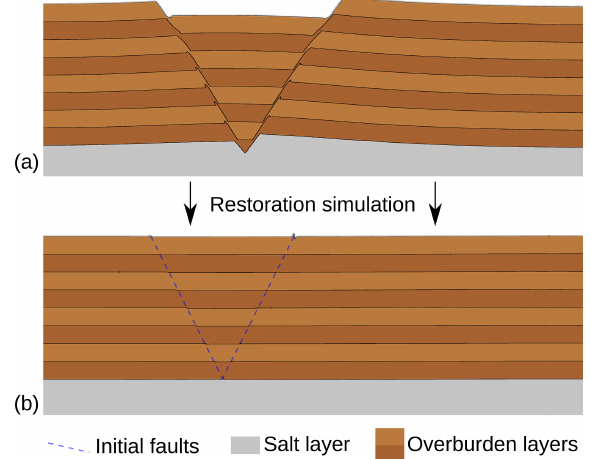
Figure 13. Results of the simulations for the simplified graben model at (a) the end of the forward simulation and (b) the end of the restoration simulation.